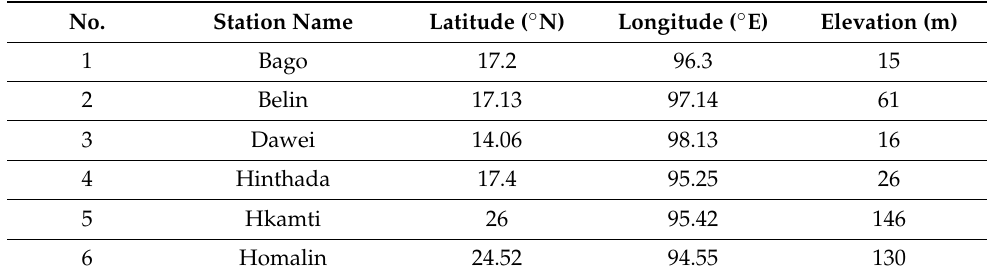
Table A1. List of weather stations with the names and their corresponding geographic locations and